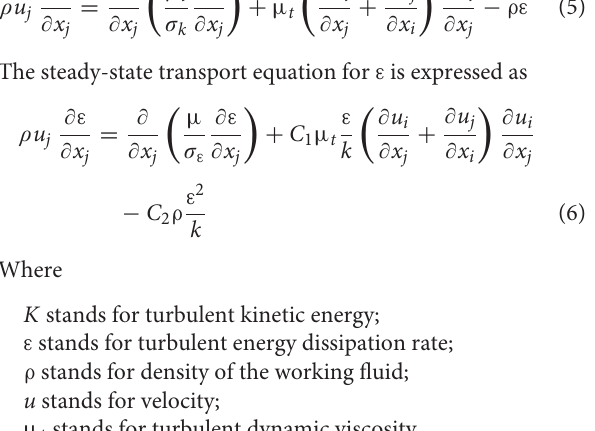
FIGURE 1 | The three dimensional geometry of six different tube arrangements for the central-type heat exchanger. (A–F) Stands for the number of six different